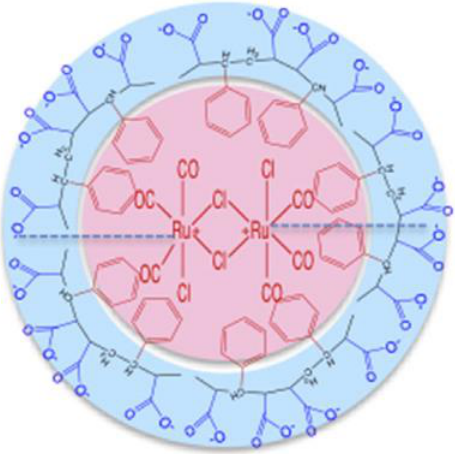
Figure 11. SMA / CORM2 micelle structure. In blue SMA formed a hydrophilic outer surface, in red CORM2 formed a hydrophobic core [76].